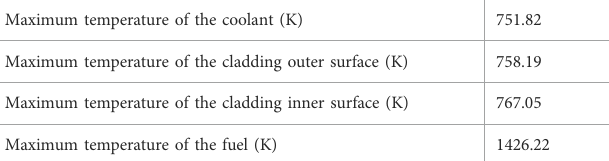
TABLE 1 Maximum temperature of different material regions.